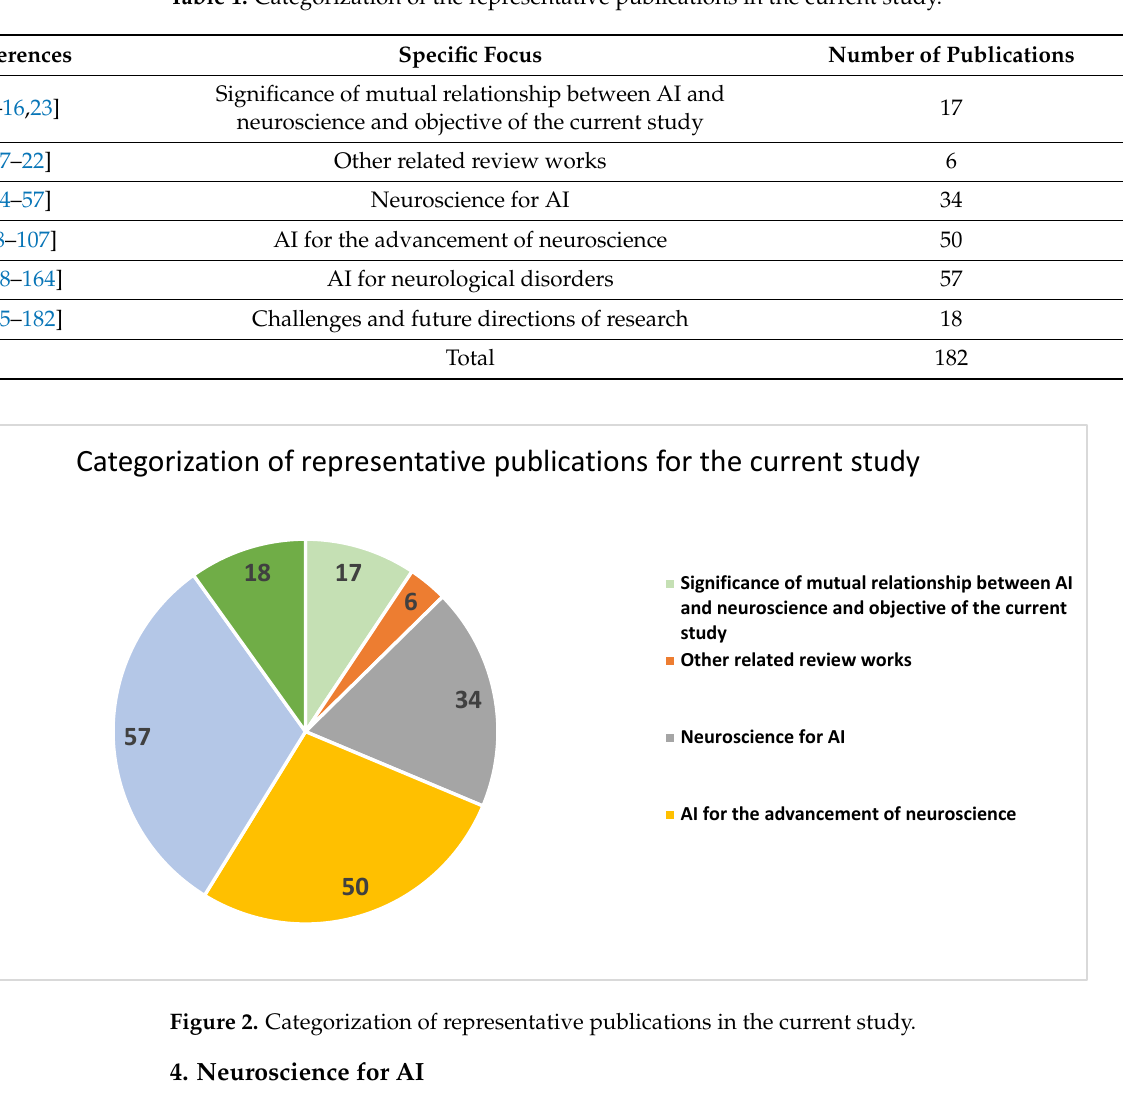
Table 1. Categorization of the representative publications in the current study.